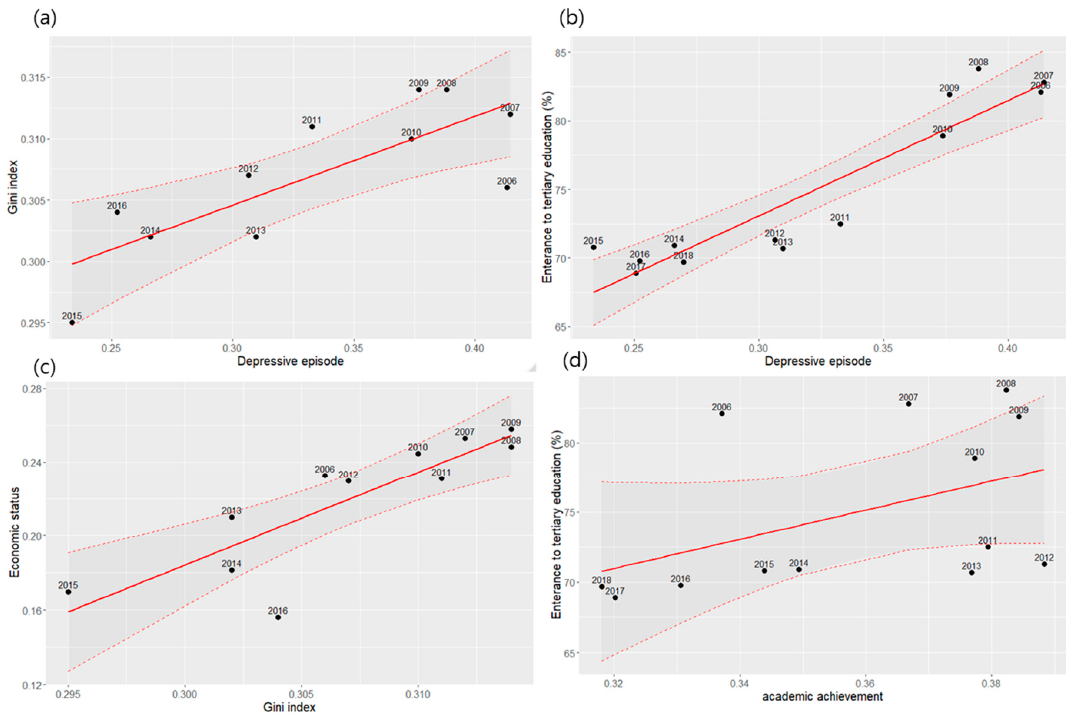
Figure 4. Correlation of the changes between social index and survey responses between 2005 and 2018.